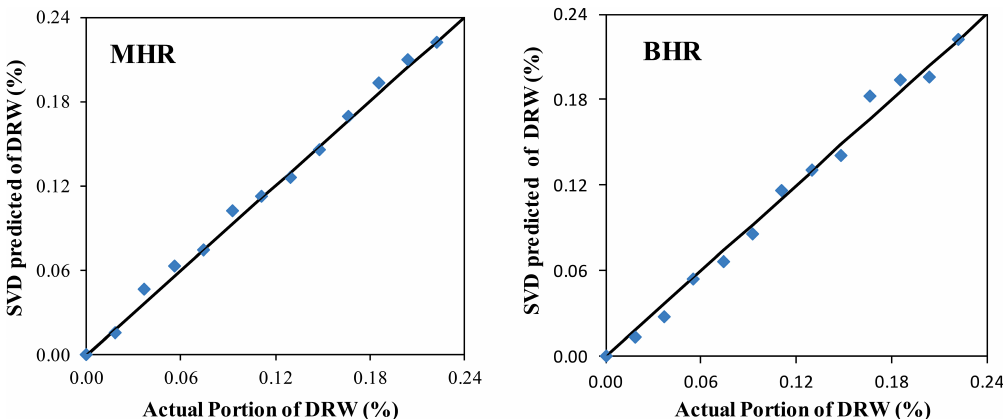
Fig. 9. Scatter plots of prediction percentage of DRW obtained from SVD analysis versus the actual percentage of DRW in MHR and